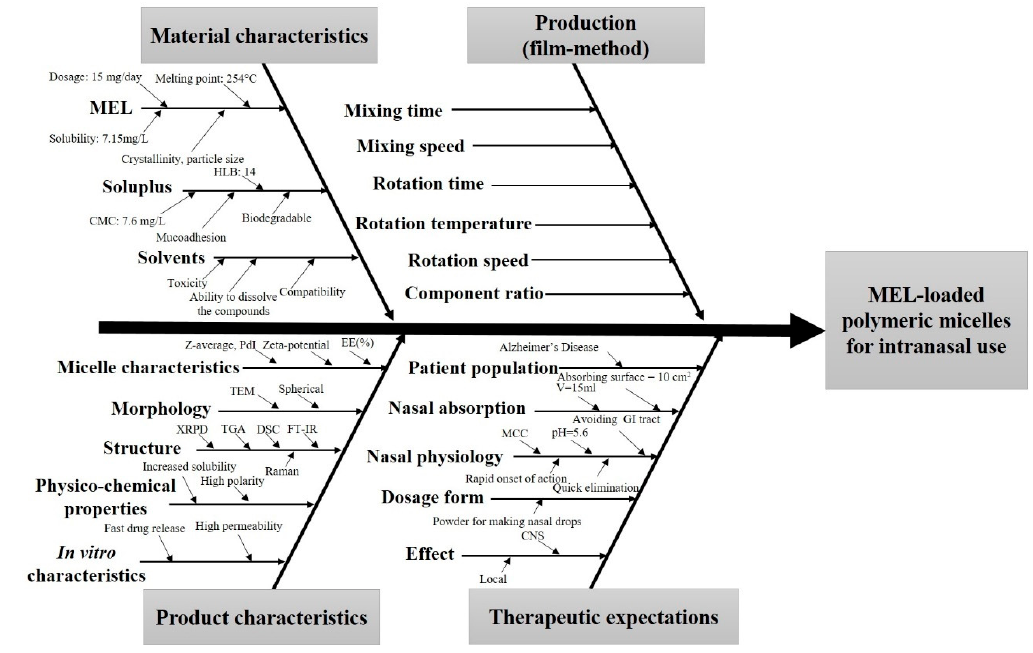
Figure 1. Ishikawa—or cause and effect diagram—of the influencing parameters of meloxicam (MEL)- containing polymeric micelles for intranasal use. Abbreviations not mentioned before: HLB— hydrophile–lipophile balance; GI—gastrointestinal; MCC—mucociliary